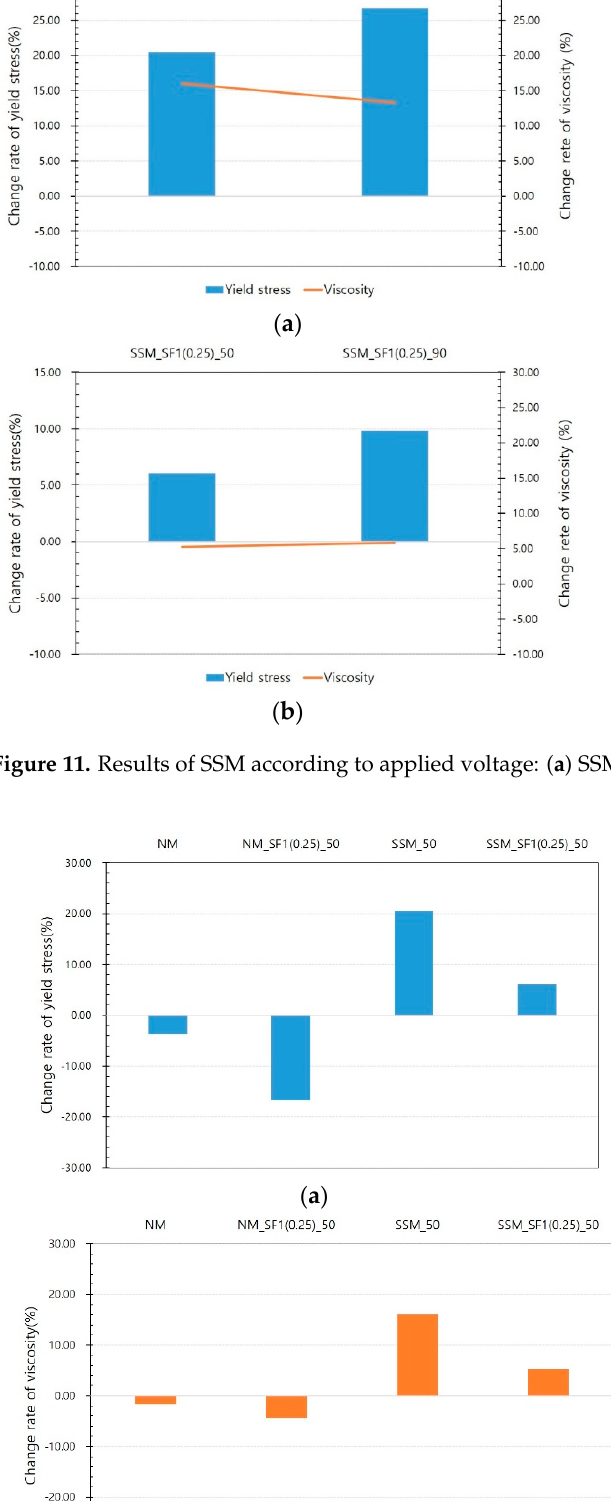
( c ) ( d ) Figure 12. Comparison between normal and steel slag mortars: ( a ) yield stress at 50 V, ( b ) viscosity at 50 V, ( c ) yield stress at 90 V, ( d ) viscosity at 90 V. 3.2. Results of Phase II Test Figure 13 shows the yield stress results of SSM and SSM_SF1 (0.25) from the Phase II test. The yield stress decreases in container 1 but increases in container 2.